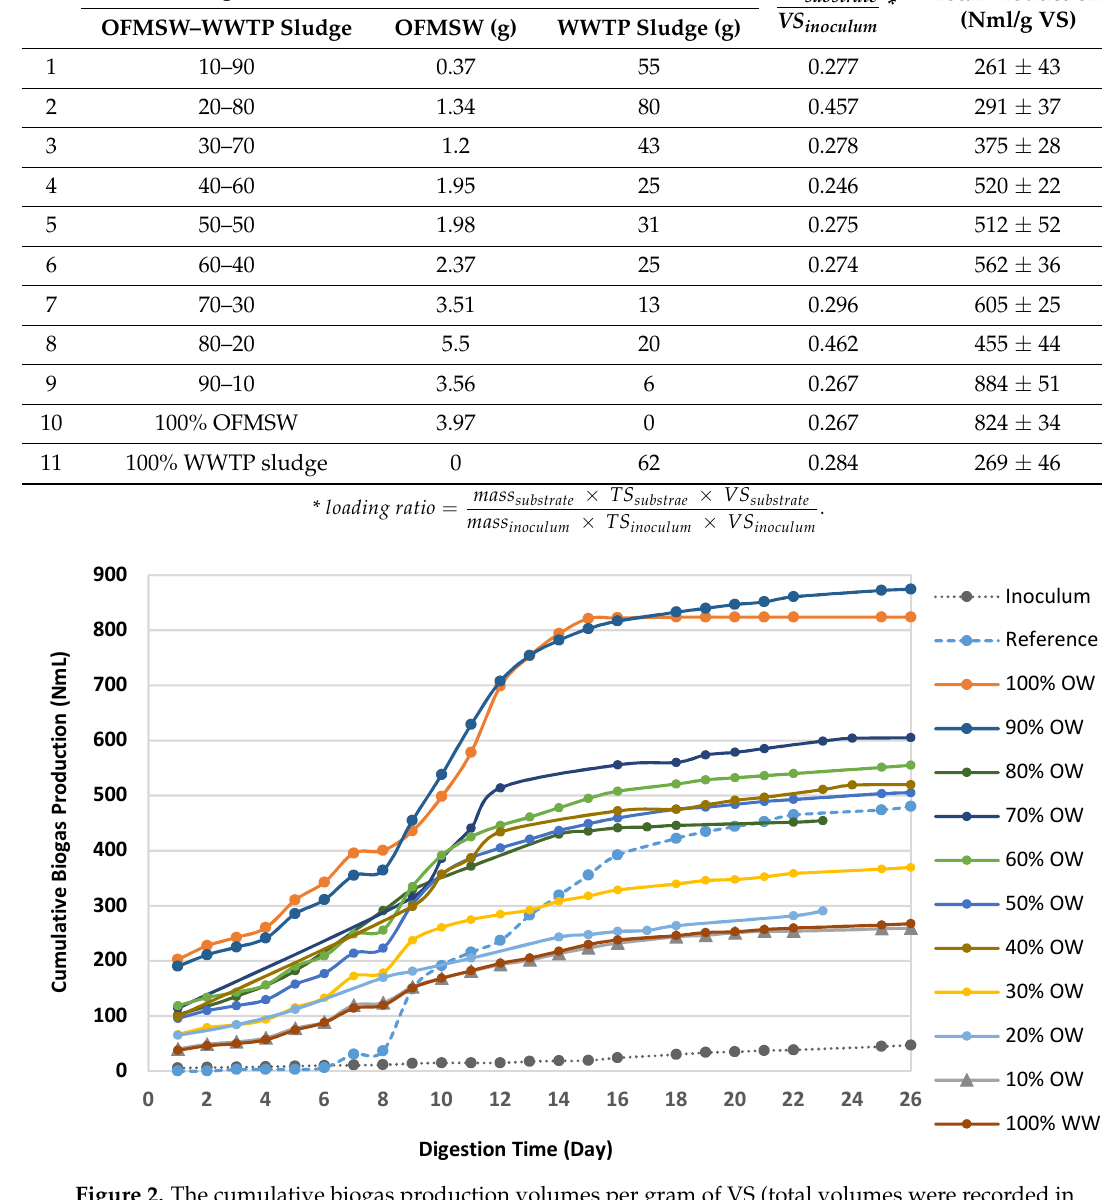
Table 4. The biogas production at different mixing ratios attained from the climate room system. Mixing Ratio Fresh Matter VS substrate Mixing Ratio Fresh Matter 𝑽𝑺